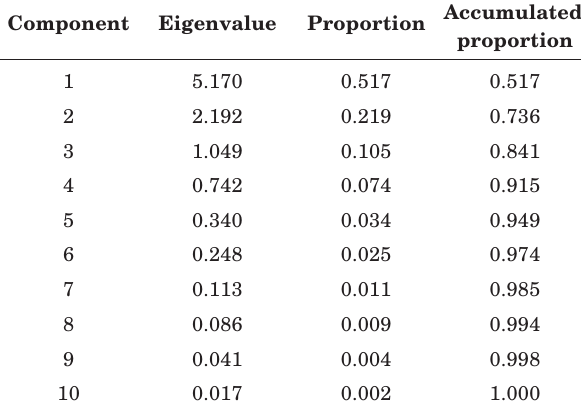
Table 3. Eigenvalue and accumulated proportion of principal component